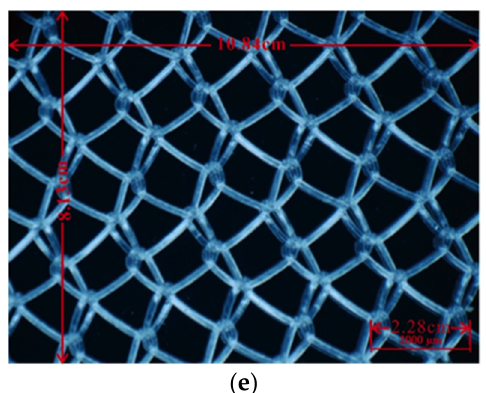
Figure 7. ( a ) Photo at 20× magnification; ( b ) Pore areas of whole picture with Magic Wand Tool; ( c ) Information on the whole picture—the red rectangle values are pixel values of the whole picture; ( d ) Information of all selected pore areas—the red rectangle value is the total pixel value of pore areas; ( e ) Computer screen scale of length and width of the image photographed at 20× magnification with the genuine scale bar at the bottom .